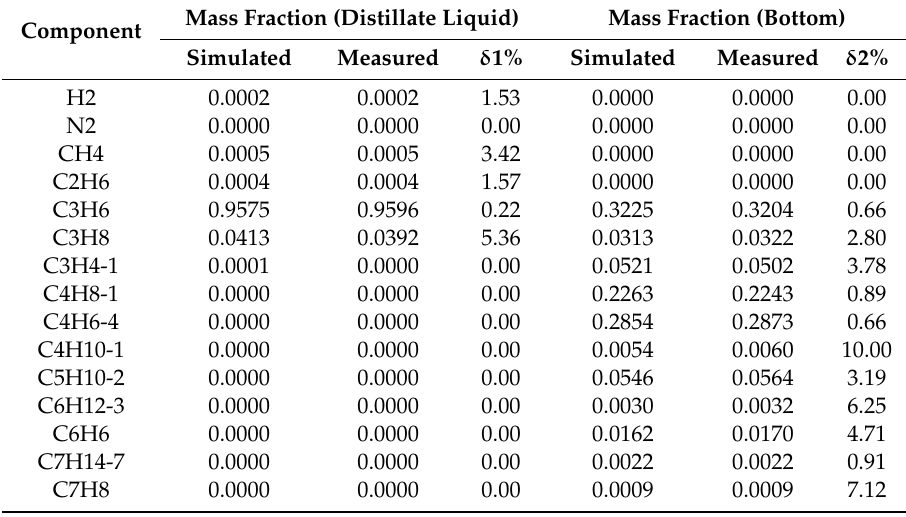
Table 7. Comparison of the mass compositions of the product flow of Example